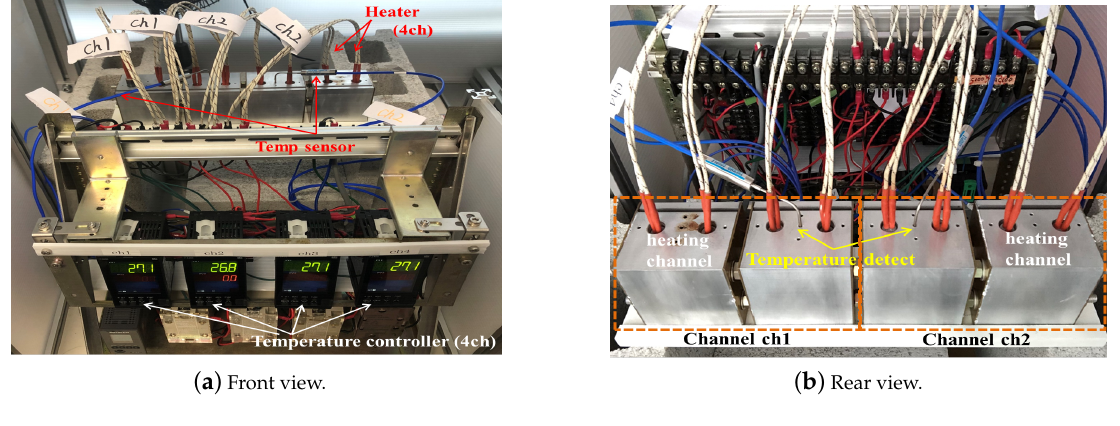
Figure 6. Experimental